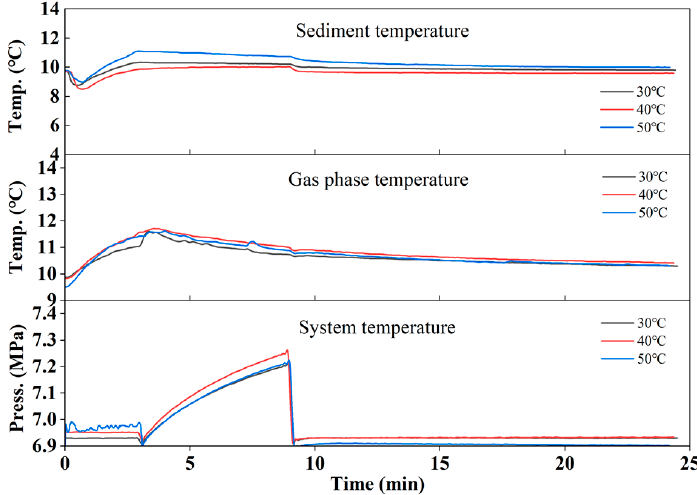
Figure 10. E ff ect of TMACl concentration on gas production. Figure 10. Effect of TMACl concentration on gas production.